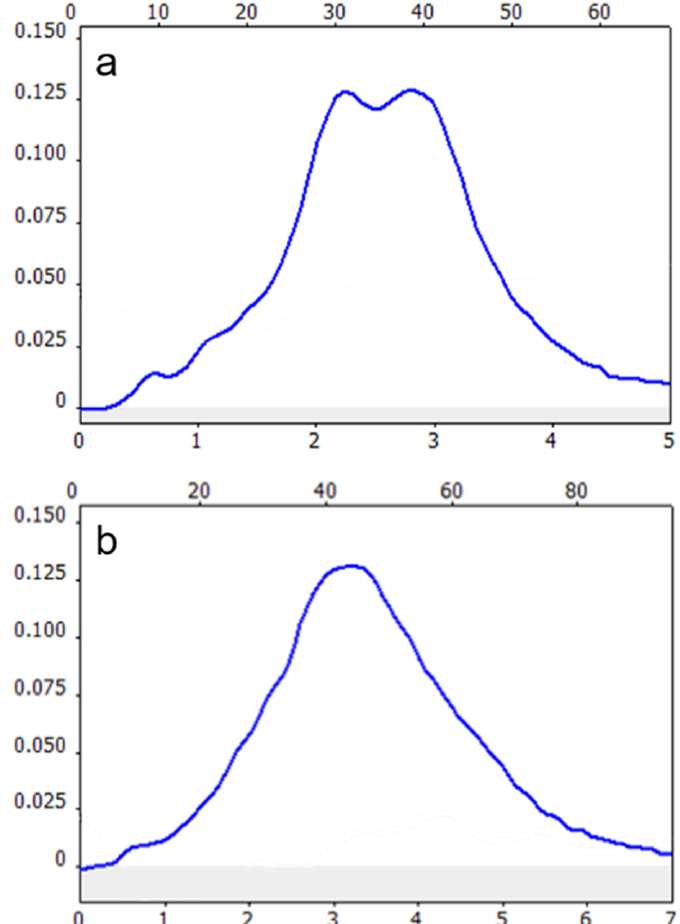
Figure 4. Shape of the time-resolved absorption signal for the determination of sulfur based on the absorption of CS at 258.0560 nm using a zirconium coated graphite tube. Double-peaked shape when employing only palladium as chemical modifier ( a ) and Gaussian-like shape when combining palladium and calcium ( b ). Table 2. Determination of the volume of palladium (10 g L − 1 ) and calcium (1 g L − 1 ) within the generation of the diatomic molecule